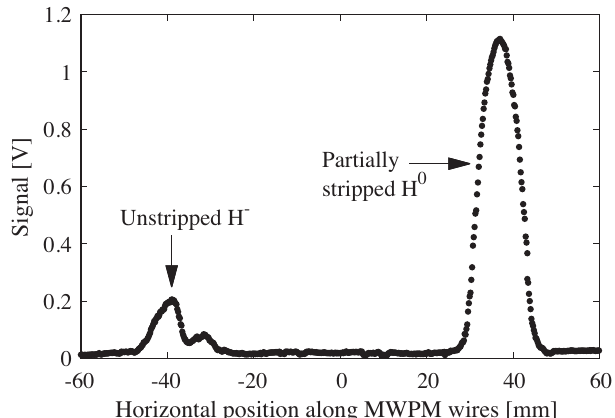
FIG. 11. Horizontal beam profiles of the unstripped H − and partially stripped H 0 waste beams measured by the MWPM at the first beam irradiation on the present HBC foil.